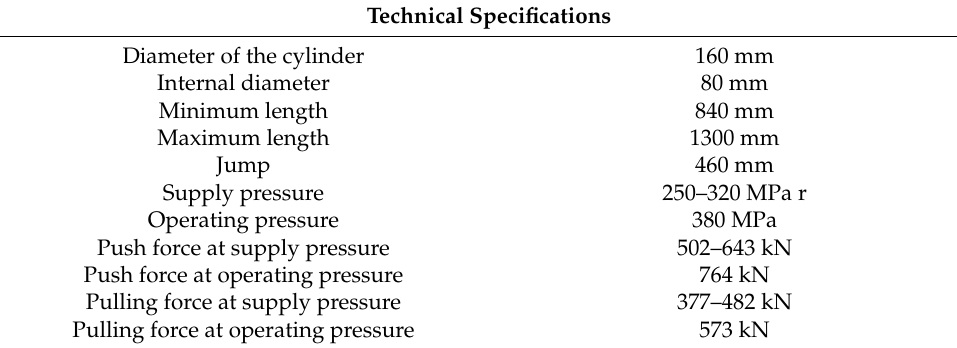
Table 1. Basic data of the analysed actuator of the powered roof